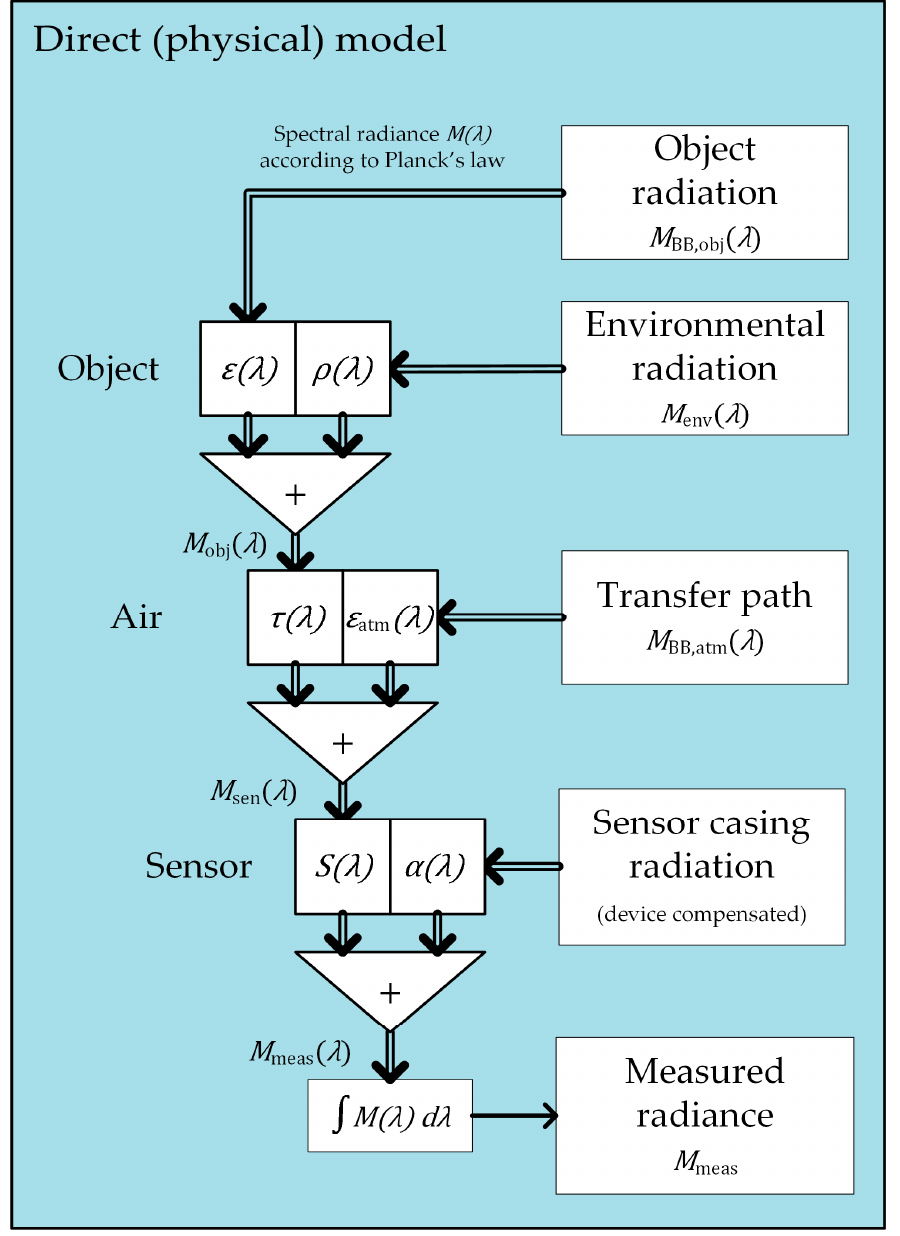
Figure 7. The direct (physical) model of radiation thermometry, describing the physical process of thermal emission, propagation, absorption and measurement of object (spectral) radiance. The rectangles represent the black body emissions, while the square and triangular operators represent the scaling and summation for the (spectral) radiance. The arrows with the double lines represent the spectral radiance, while the single-line arrows represent the radiance (the total radiant power without spectral information). (cid:16) (cid:17) T obj , λ Figure 8a presents the raw spectral radiances M BB,obj , M env ( λ ) and M BB,atm ( T atm , λ ) of the three contributing sources of radiation. Figure 8b presents the influence parameters ε ( λ ) , τ ( λ ) and S ( λ ) . Figure 8c presents the detected spectral radiance of the three contributing sources, as expressed in Equation (15) prior to integration, and the sum of the three, as expressed in Equation (14) prior to